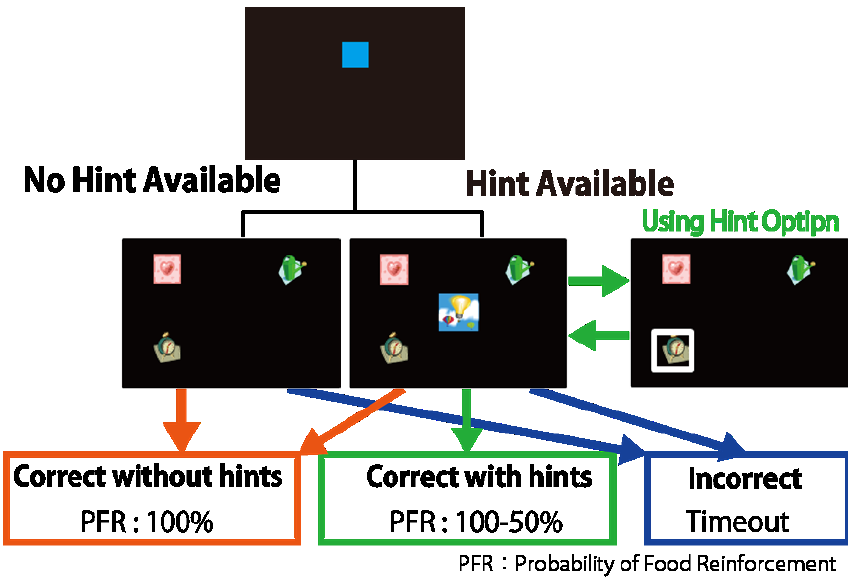
Figure 1 . A schematic representation of Iwasaki et al. (2013). After pecking a self-start key, subjects faced solving a three-item simultaneous chaining task. In half of the trials subjects were given to a hint option which showed the next response (Hint Available trials). In other trials, hints were unavailable (No Hint Available trials). All correct responses without hints were reinforced by food, but 50-100% of correct responses with hint trials were reinforced. Incorrect responses resulted in a timeout irrespective of whether a hint was used. From Iwasaki, S. et al. (2013). Do pigeons ( Columba livia ) seek information when they have insufficient knowledge? Animal Cognition , 16, 211 – 221. Copyright 2015 by Springer